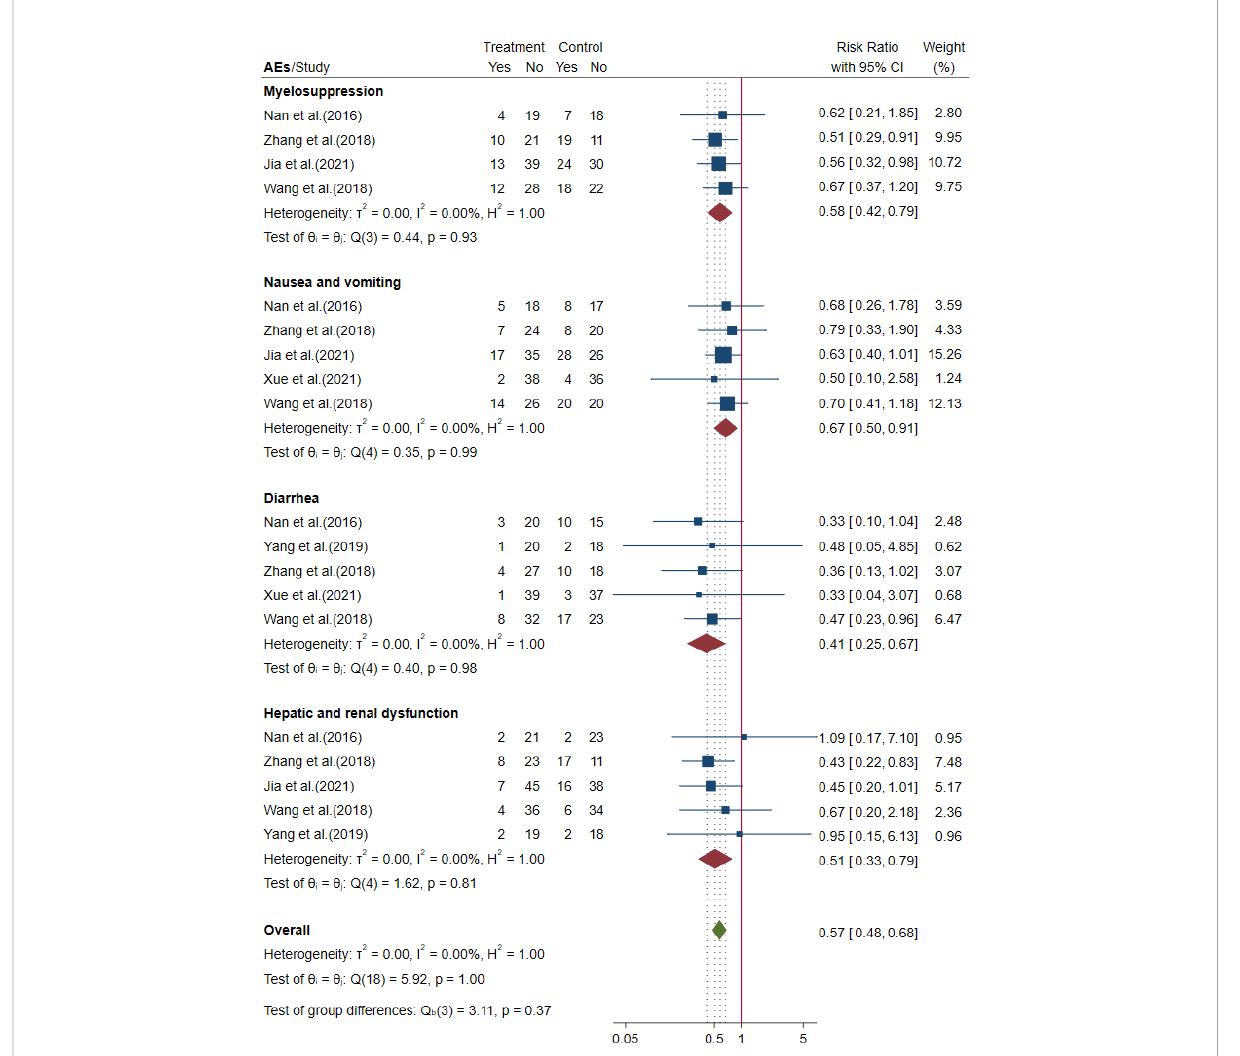
FIGURE 11 Forest plot of incidence of adverse events (AEs) in advanced colorectal cancer